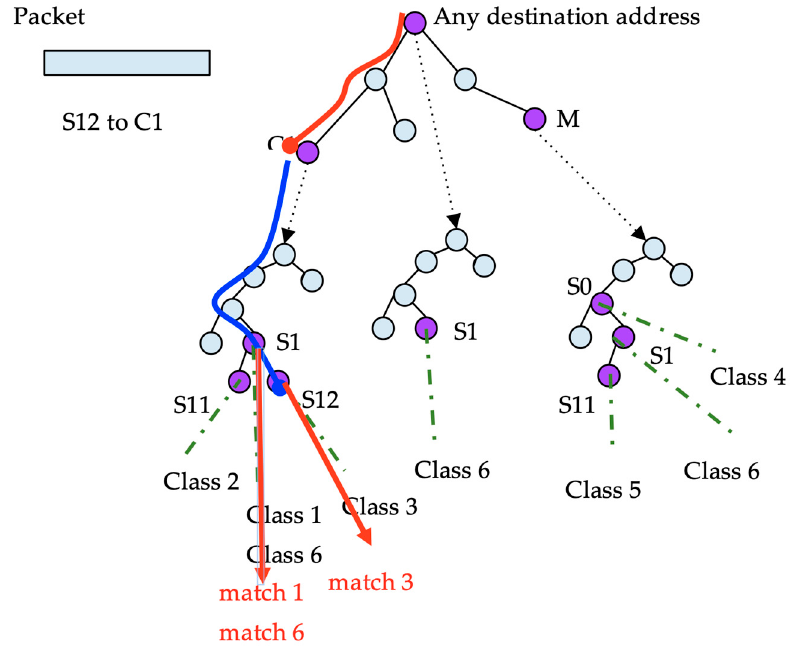
Figure 8. Search example traversing a set-pruning DStrie.